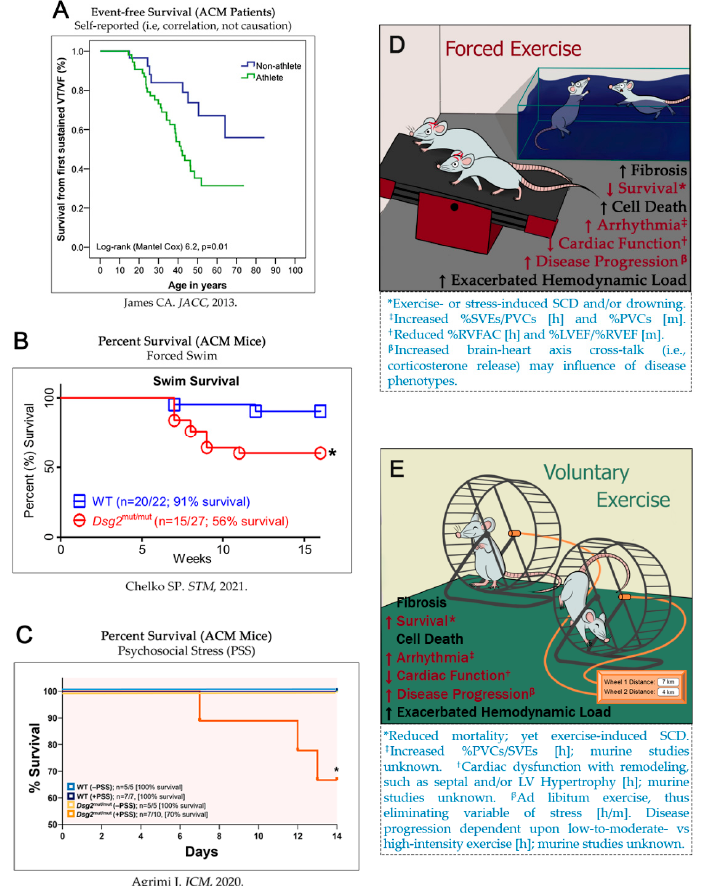
Figure 1. Survival analyses in ACM subjects. ( A ) Event-free survival from VT/VF in ACM patients. ( B ) Percent survival in ACM mice subjected to forced swim or ( C ) psychosocial stress. Graphical abstract demonstrating mice under stress whilst performing forced exercises ( D ), during voluntary exercise ( E ) demonstrates no psychological and/or psychosocial stress in mice. For ( D , E ), prior research outcomes *, ‡ , † , β correspond with the text immediately below the image. [h], human; [m] murine studies. For ( A – C ) , images are reprinted with permission from ( A) [94] (2103, Elsevier), ( B) [102] (2021, Chelko S.P.) and ( C ) [97] (2020, Chelko S.P.).